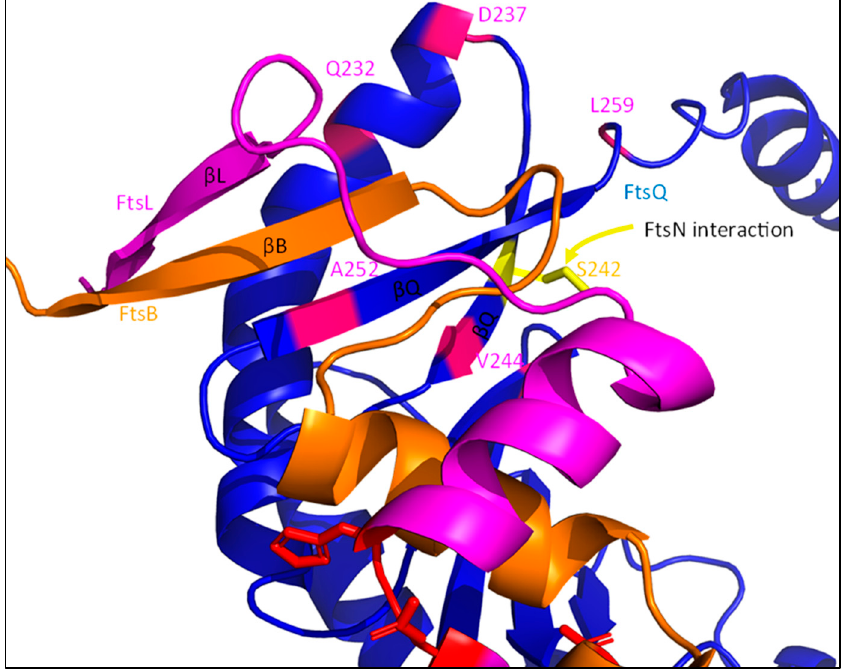
Figure 15. FtsBLQ C-terminal interaction. The C-terminal domain of FtsQ interacts with FtsB, through the formation of a multi-stranded β -sheet ( β L, β B and β Q). Stability in this domain is important for the interactions, as mutating the residues marked in purple has a negative effect on FtsQ–FtsB interaction. Furthermore, a C-terminal interaction between FtsB and FtsL is predicted, as FtsL forms a β -strand interacting with the FtsB–FtsQ β -sheet ( β L). This may be stabilized further by FtsQ. An additional FtsN-binding residue can be found in this region of FtsQ (S242; yellow) which is vital for FtsN–FtsQ interaction. This FtsN interaction may induce instability in this region, thus changing the conformation of FtsBL to an activation one.